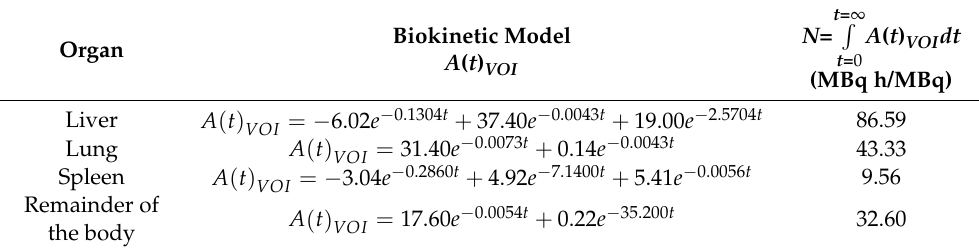
Table 7. Biokinetic models of 177 Lu 2 O 3 -iPSMA nanoparticles, calculated from a patient with multiple colorectal liver metastases.